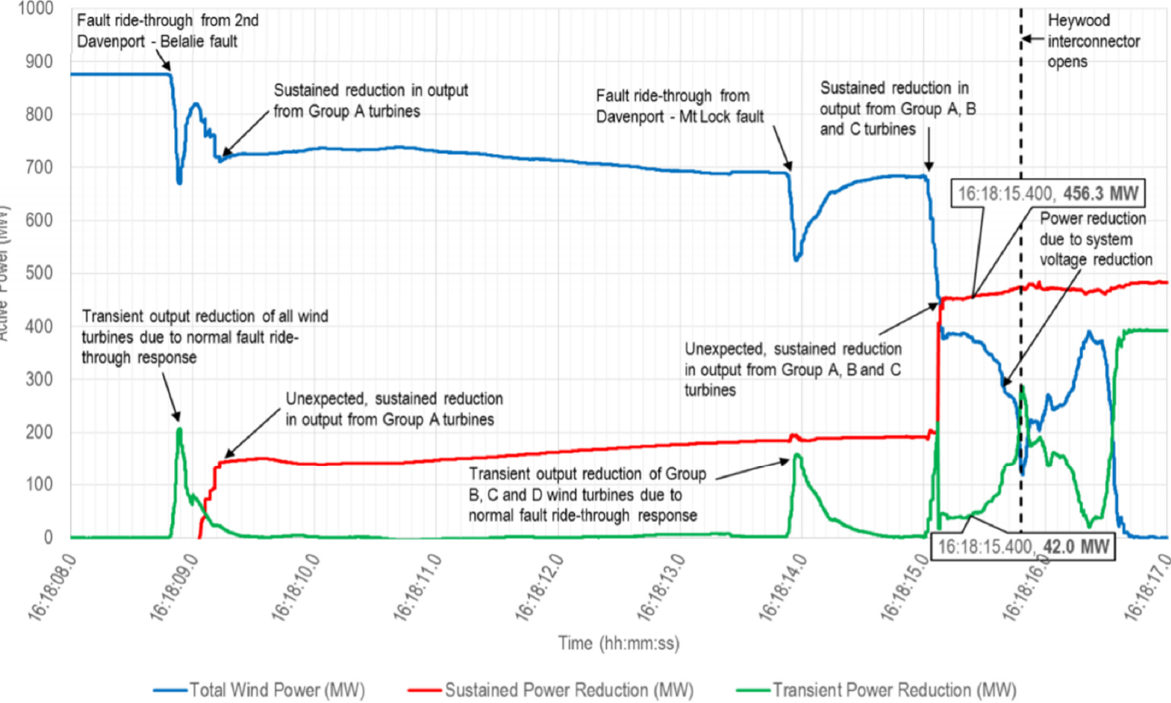
Figure 8. Dynamics of wind farms in South Australian power system during the incident on 28 September 2016 [73].